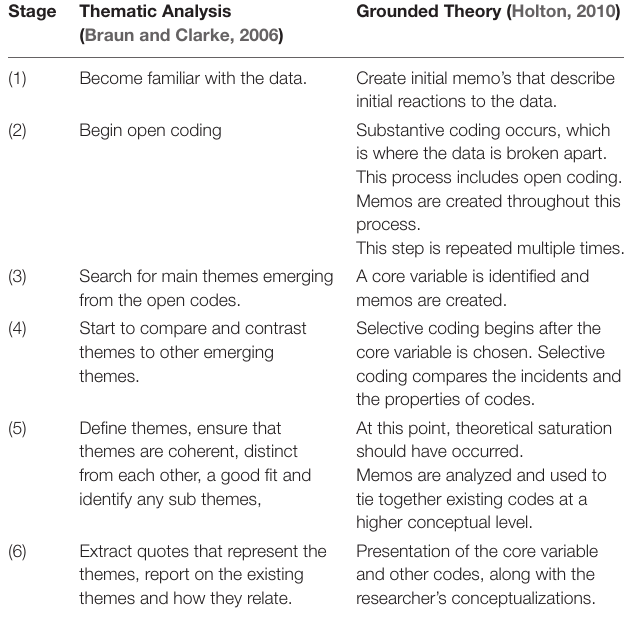
TABLE 1 | Description of data analysis